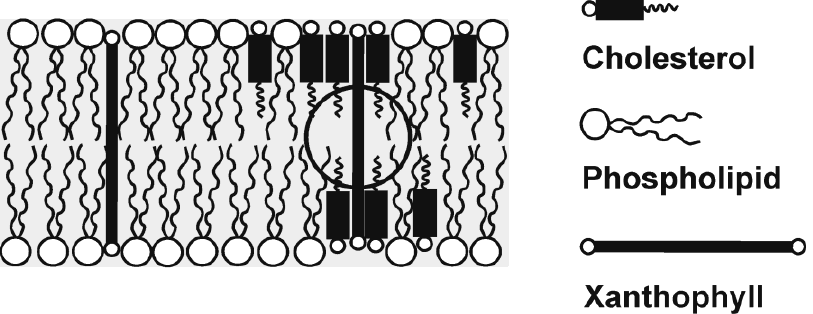
Figure 3. Schematic drawing showing the location of the xanthophyll molecule in the cholesterol-rich and cholesterol-poor membrane domains. An unfavorable interaction with cholesterol in the cholesterol-rich domain is indicated.